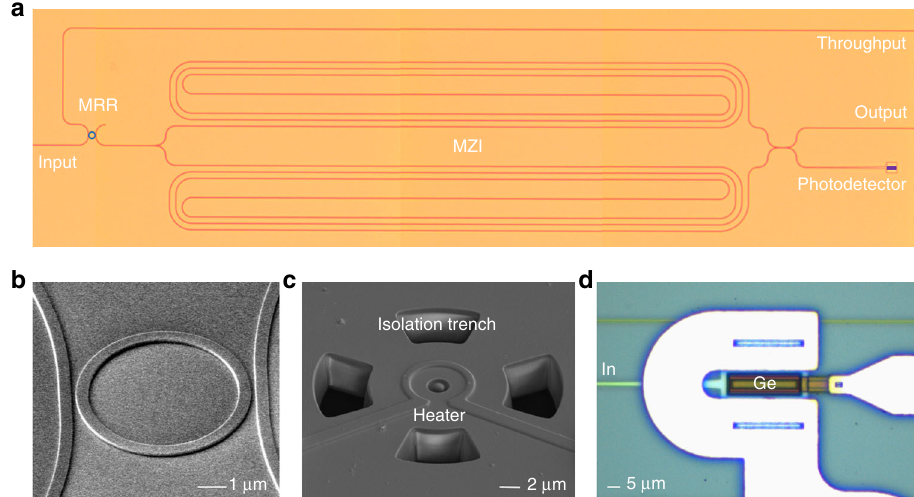
Fig. 3 Fabricated RAFT spectrometer. a False-colored optical micrography of a RAFT spectrometer after Ge epitaxy growth for PD. b SEM image of an MRR without SiO 2 upper cladding. c SEM image of a tunable MRR with isolation trenches and TiN heater. d Optical micrography of a waveguide-coupled Ge-on- SOI photodetector